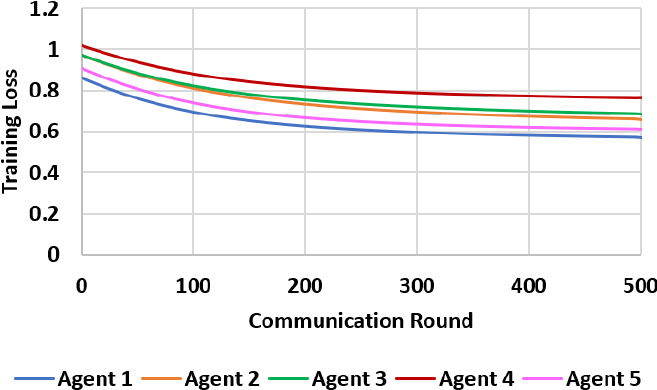
Figure 19. FedResilience’s impact on participating FL agents’ (five agents and three stragglers) model loss for the prediction of CIA outages.